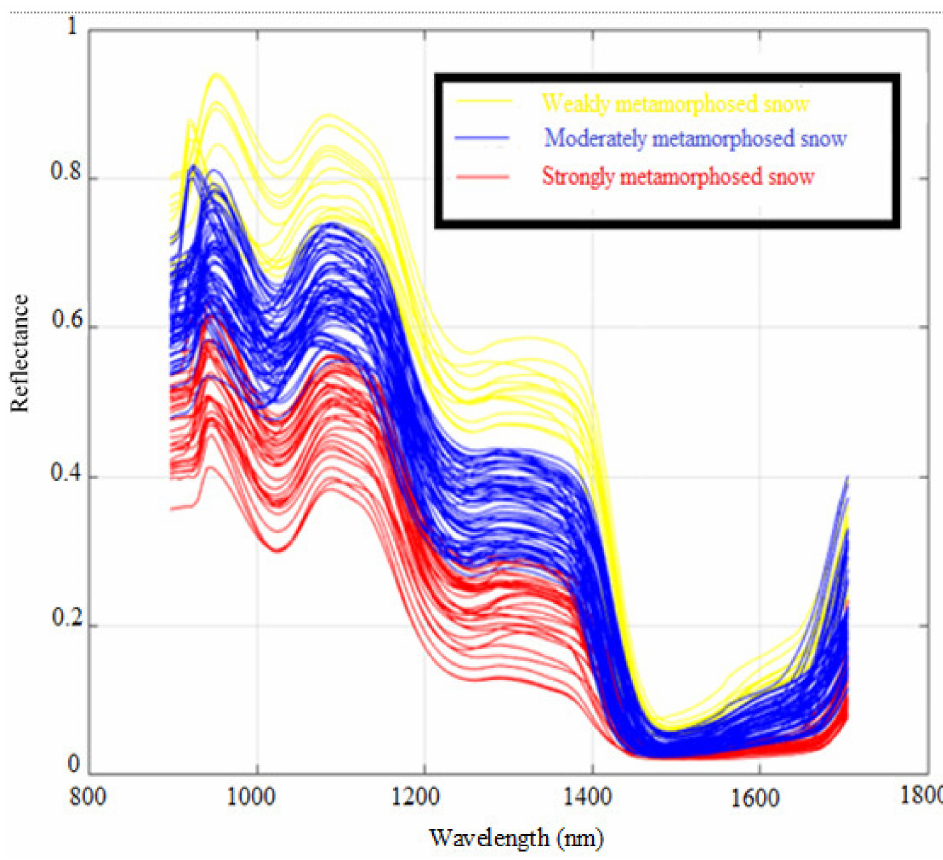
Figure 14. The near-infrared spectral reflectance values of the three snow